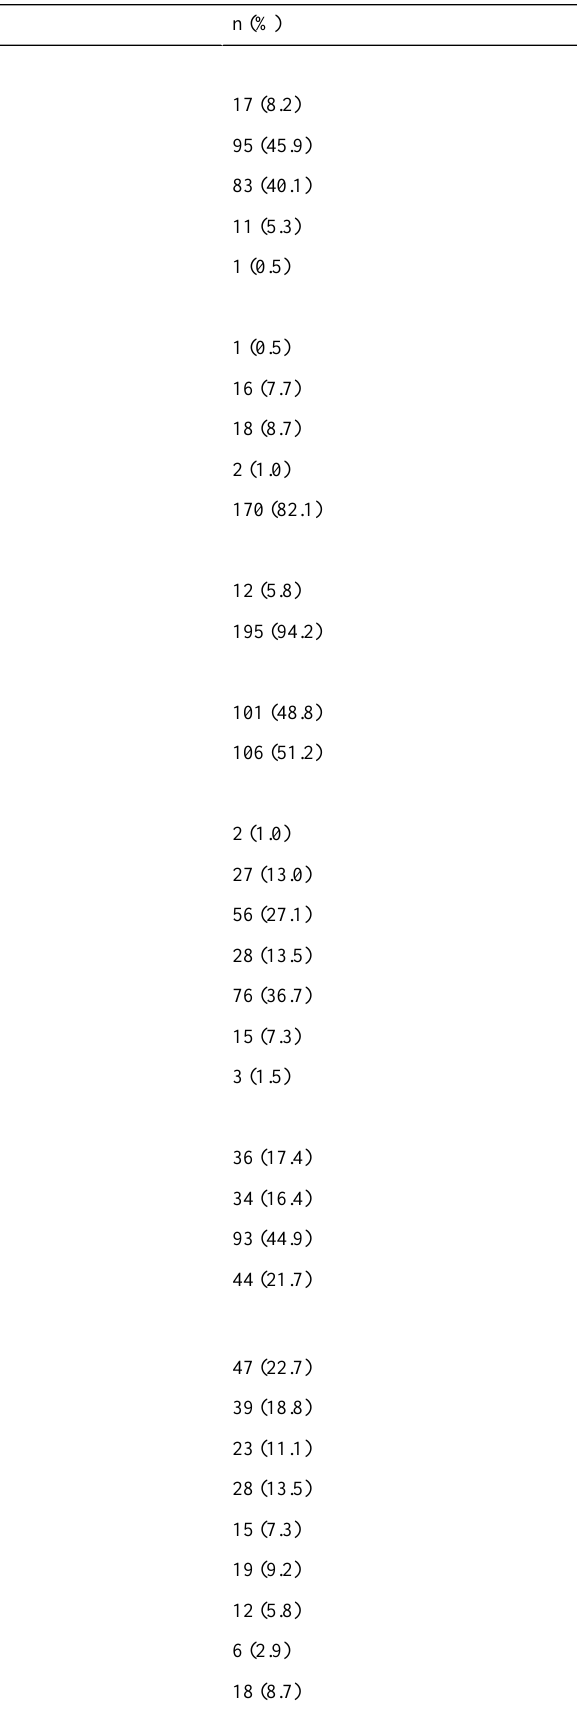
Table 1. Demographics